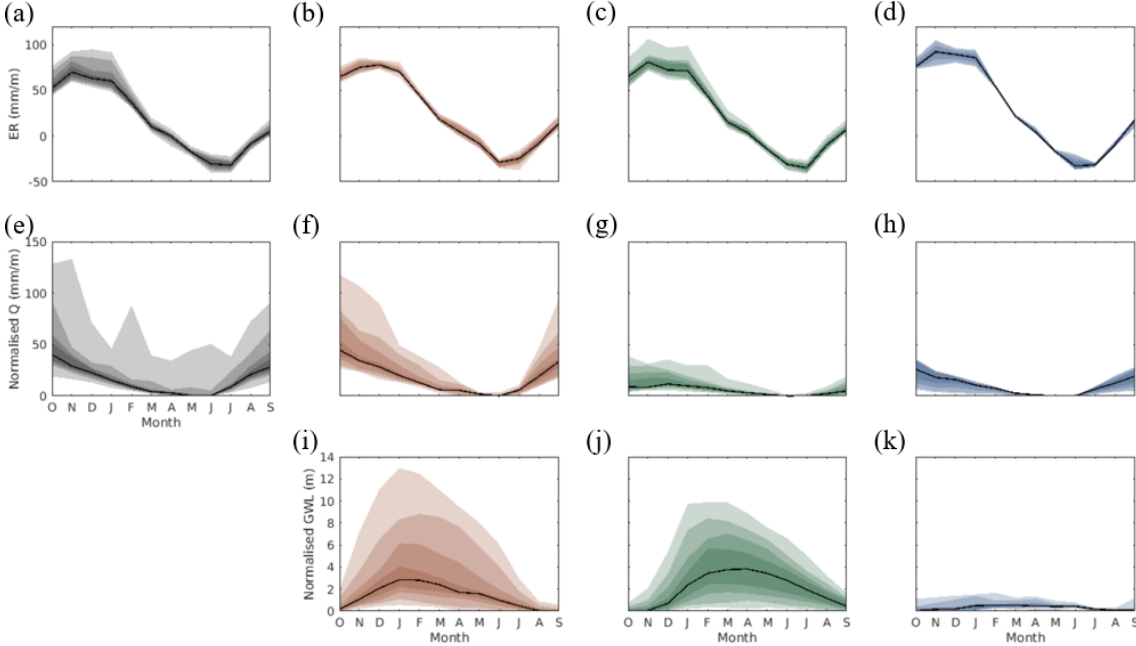
Figure 7. Seasonal patterns of (a–d) effective rainfall ( P − AET), (e–h) normalised naturalised discharge and (i–k) normalised groundwater levels for non-aquifer, Jurassic limestone, Chalk and Lower Greensand reaches (in shades of grey, orange, green and blue respectively). Reaches have been categorised based on a minimum of 70% geological aquifer outcrop coverage at the surface. The dark black lines show the mean of the data and the shaded bands represent the 95th, 85th, 75th and 65th percentiles of the data. Table 2. Seasonality and lags of the 50th percentiles of precipitation, groundwater level and river flow. Reaches categorised based on a minimum of 70% geological aquifer outcrop coverage at the